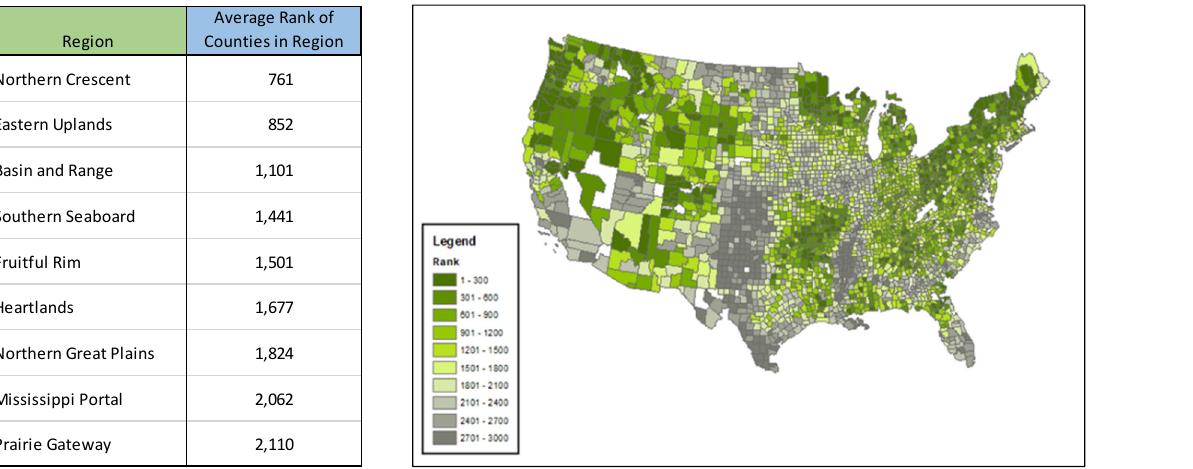
Table 7. Region Ranking, On-Farm Operators, 2012 Map 6. On-Farm Operators Rank,